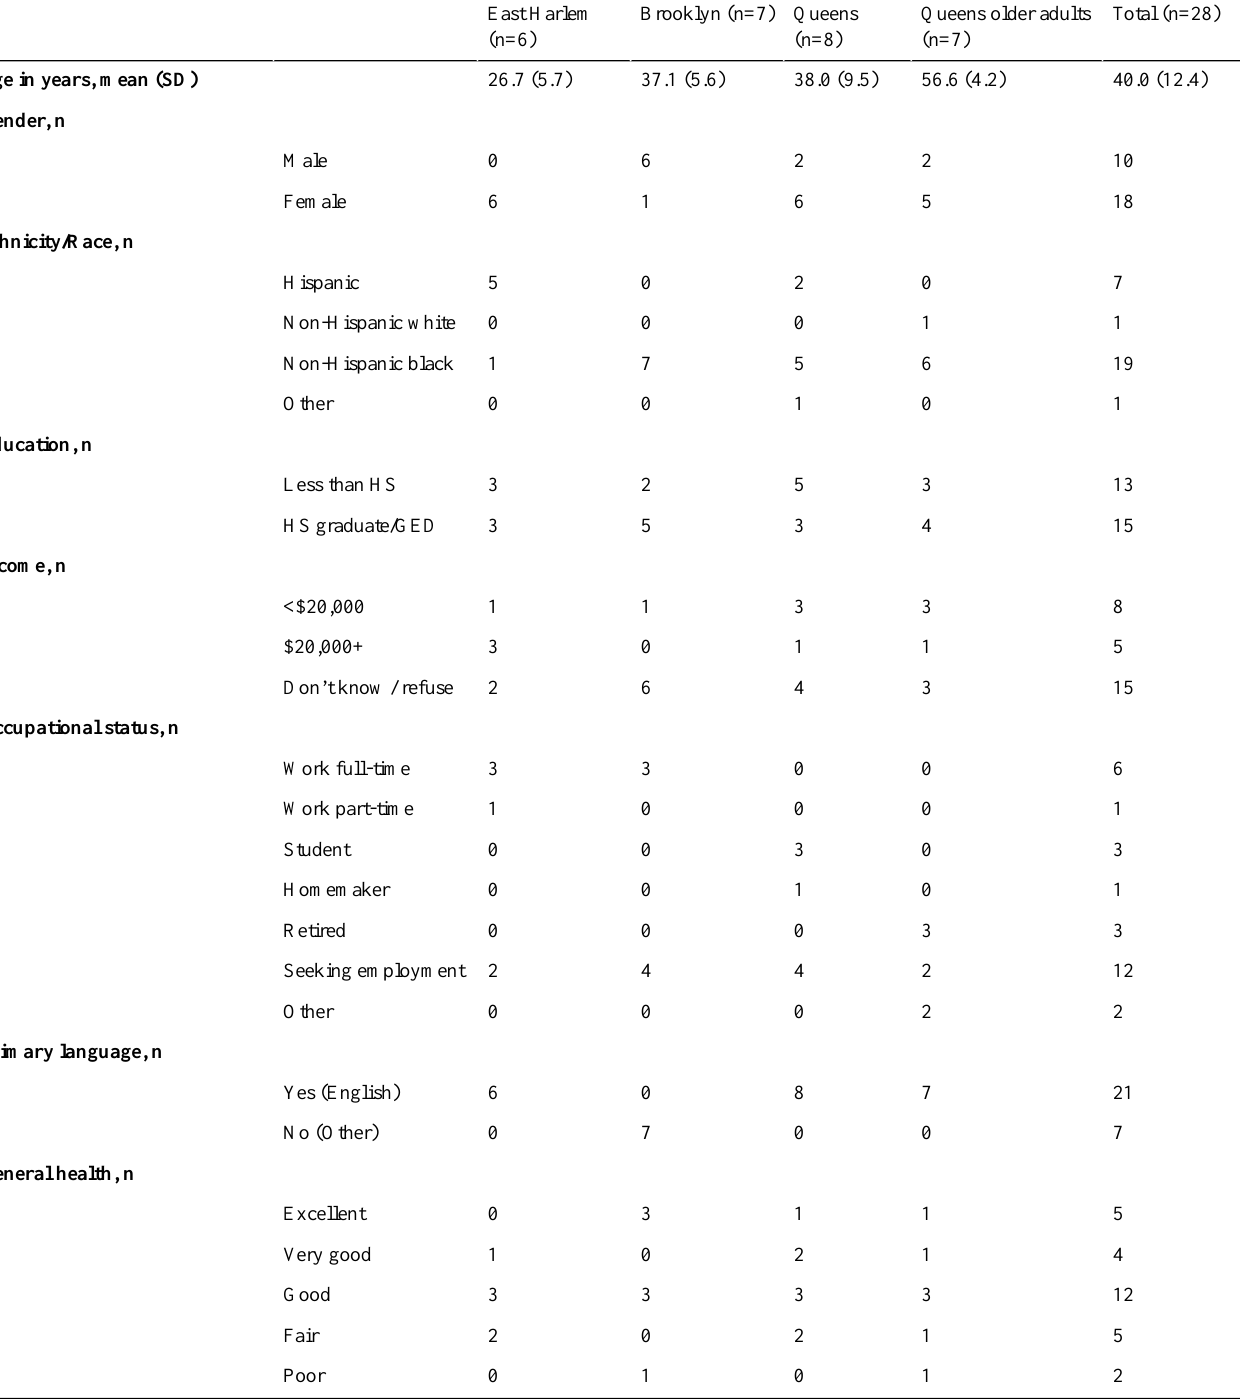
Table 2. Participant demographics